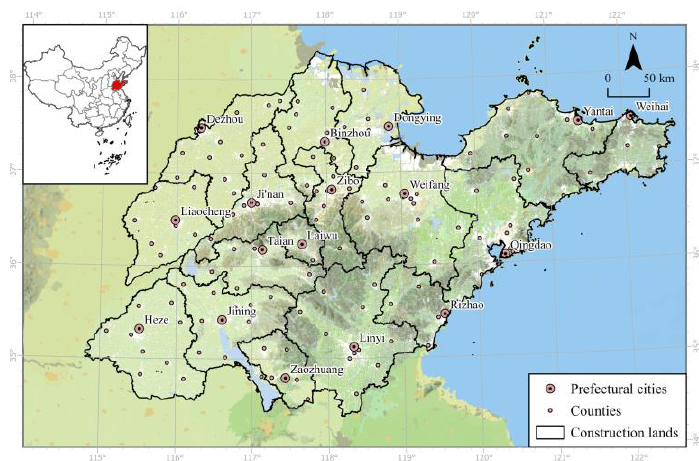
Figure 2. Location and topology of Shandong Province.